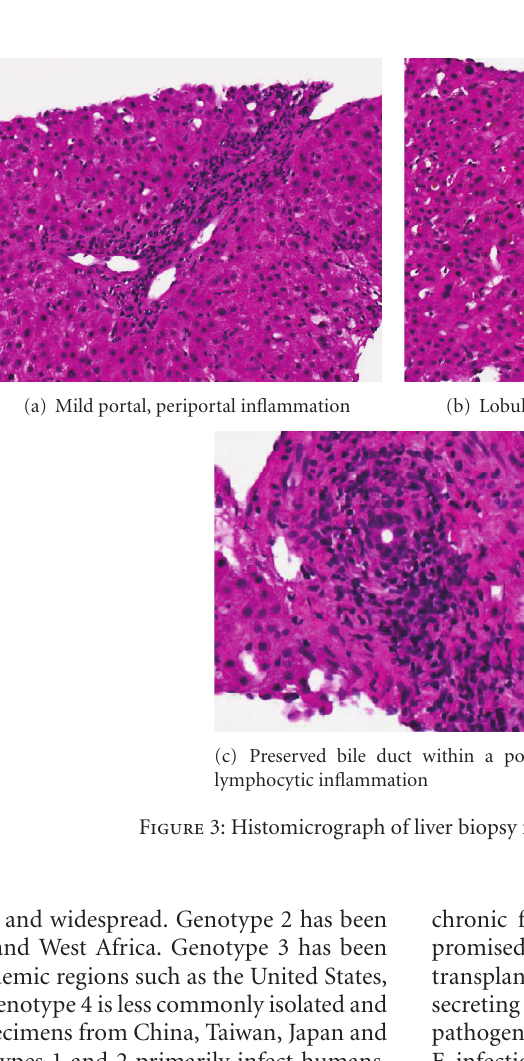
Figure 2: Histomicrograph of liver biopsy in December 2009.